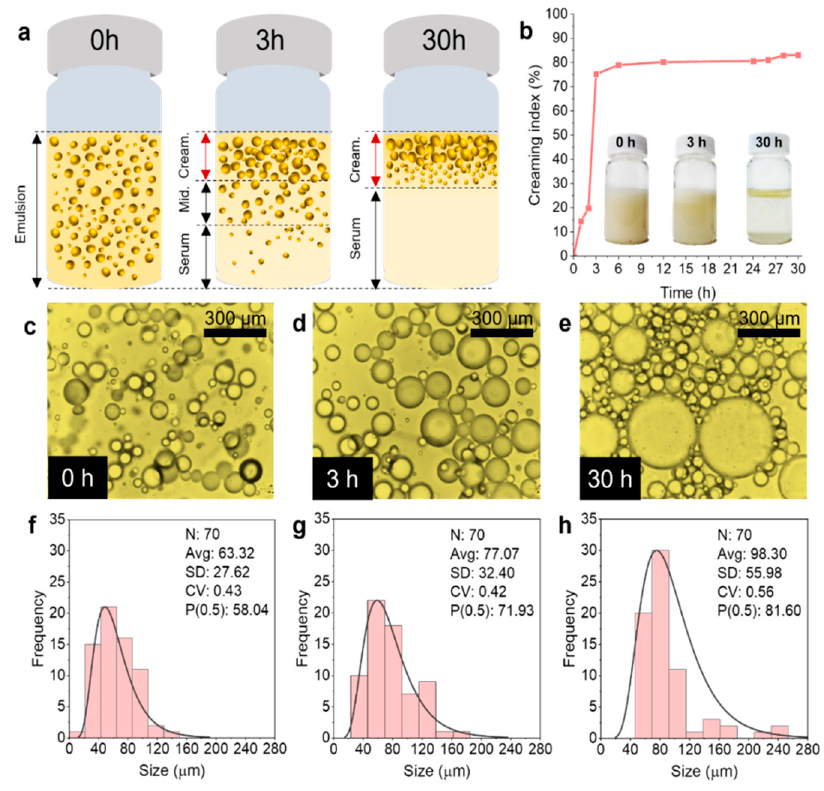
Figure 4. ( a ) Representation of the creaming evolution over time; ( b ) Results of creaming index measurements over time; ( c–e ) Fluorescence microscopy images showing the droplet size evolution over time (0 h, 3 h, and 30 h, respectively); and ( f–h ) frequency histograms of the droplet diameter fitted to a log-normal distribution at 0 h, 3 h, and 30 h.